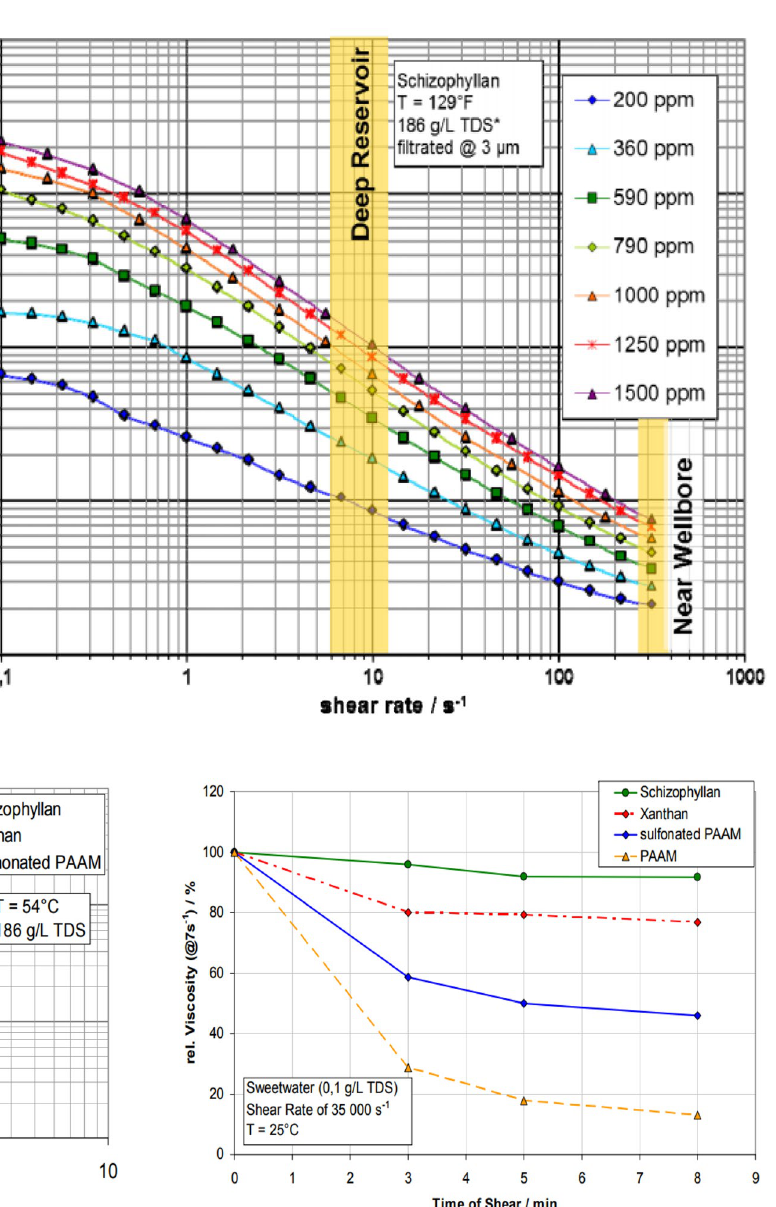
Fig. 3 Rheology of schizophyl-